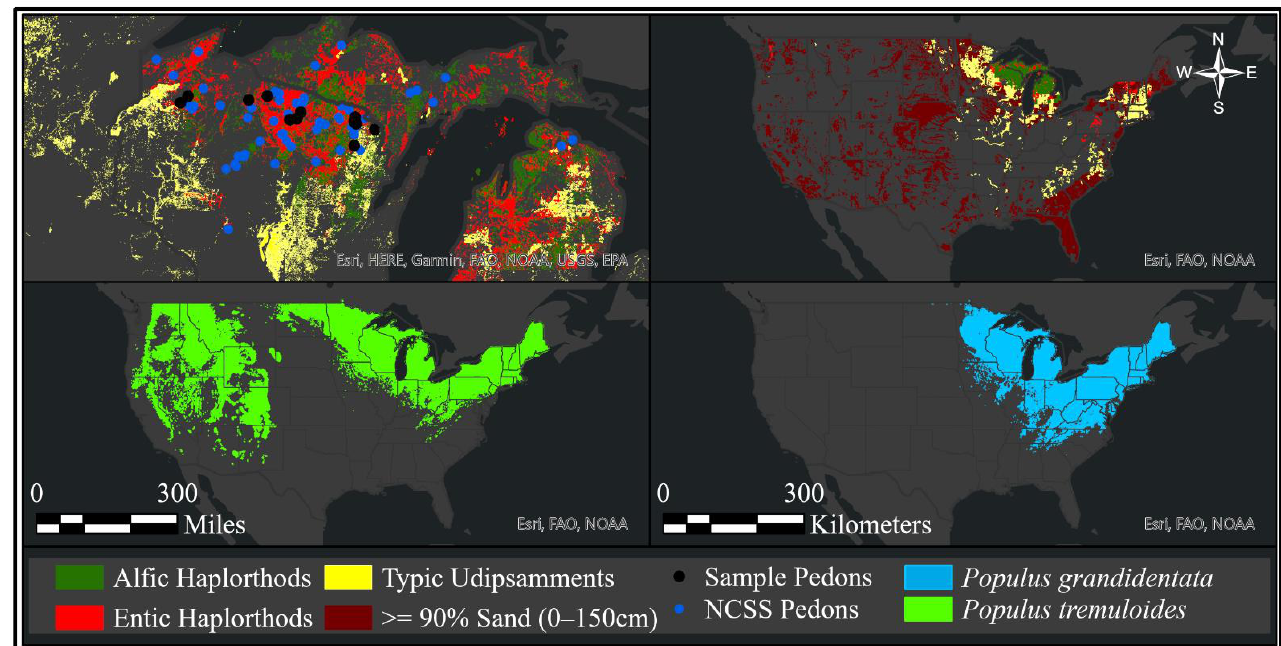
Figure 1. The major nutrient-poor outwash (Typic Udipsamments-Entic Haplorthods), glacial till (Alfic Haplorthods), and low silt + clay soils from the gridded Soil Survey Geographic (gSSURGO) database. The sample pedons were collected with NRCS soil scientists to increase available pedons in outwash soils, and NCSS pedons were retrieved from the database for the outwash and glacial till soils. The aspen species within this study have large ranges across North America and are shown within the United States (derived from [26]).